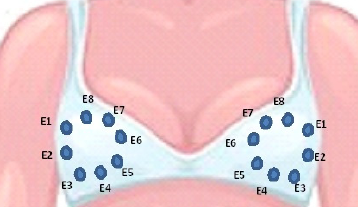
Figure 1. Distribution of the electrodes E1–E8 in the latex cups.